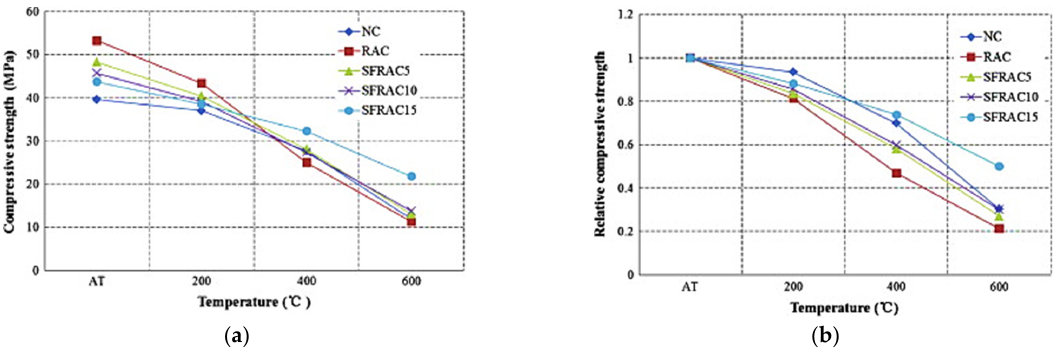
Figure 10. Effect of elevated temperatures on ( a ) compressive strength and ( b ) relative compressive strength of recycled concrete reinforced with SF. Copyright permission is obtained from [50].